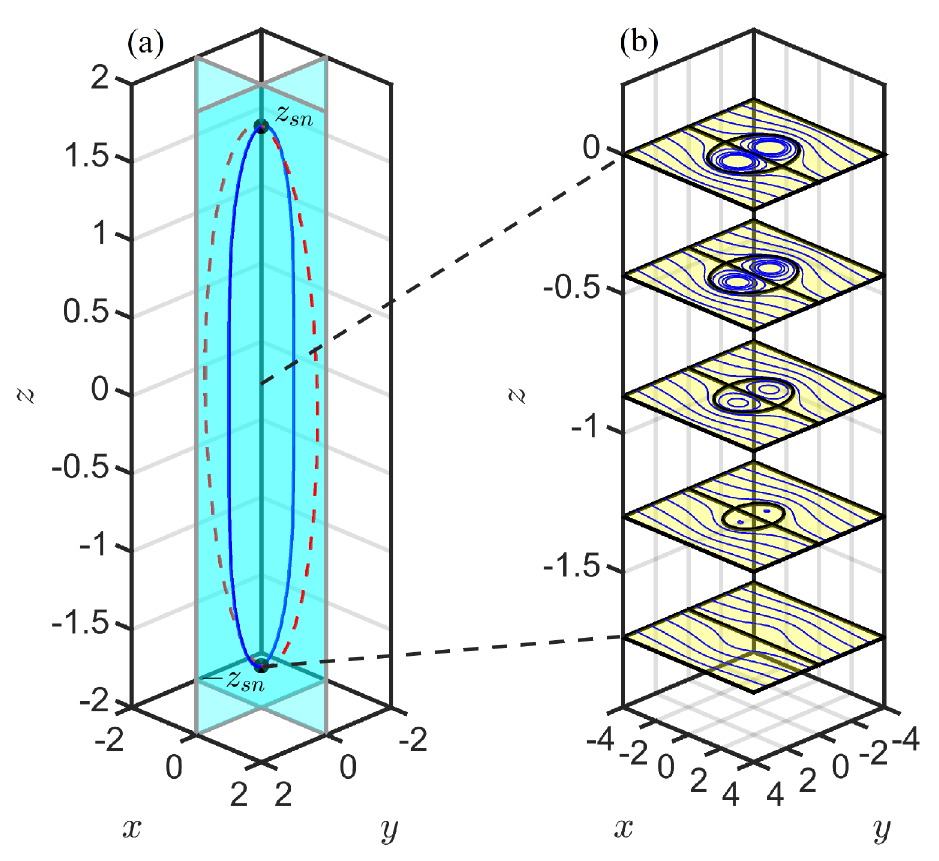
Figure 3. Bifurcation diagram ( a ) and contour slices ( b ) for the Z = 0 case. Panel ( a ) illustrates the generation/destruction of stable (solid blue curves) and unstable (dashed red curves) fixed points. At −√ z = − z sn = 3, a double saddle-node bifurcation leads to the creation of two pairs of fixed points. The stable pair is on the x = 0 plane, and the unstable pair is on the y = 0 plane. These fixed points are destroyed by another double saddle-node bifurcation at z = z sn = panel ( b ) illustrate the three-dimensional volume trapped by the heton at five equally spaced planes −√ between z = 3 and z =